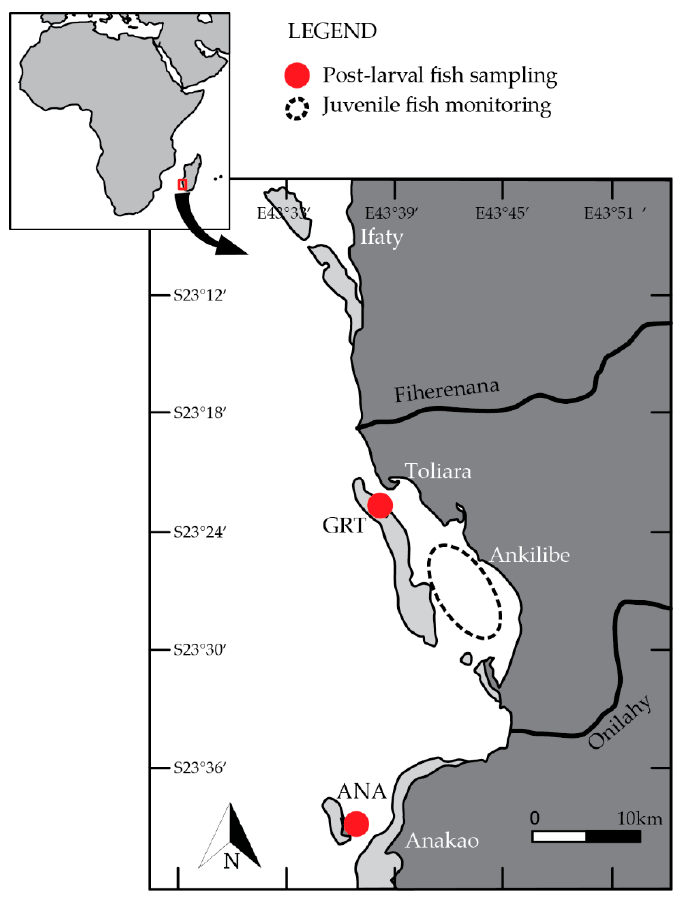
Figure 1. Locations of the sampling sites for post-larvae (red circles) and juvenile fish (dotted circle). With ANA = Anakao reef, and GRT = Great Barrier Reef of Toliara.